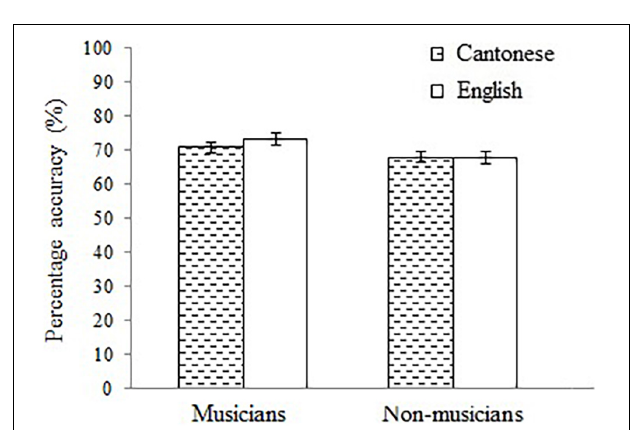
FIGURE 2 | Mean rhythm score of the Cantonese musicians, Cantonese non-musicians, English musicians, and English non-musicians. The error bars represent the standard error of the